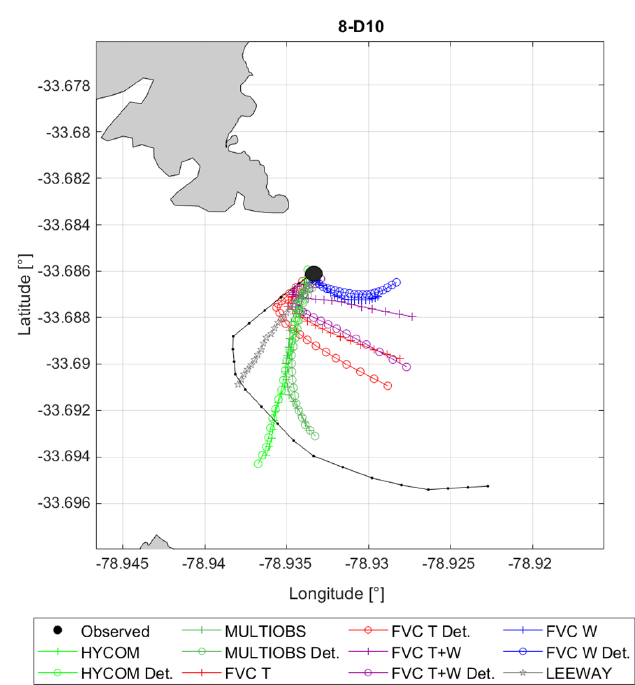
Figure 14. Zoomed-in trajectory of drifter 8 on 10 September 2011. FVC = FVCOM; T = Tide; W = Wind; Det. = deterministic (drag force)